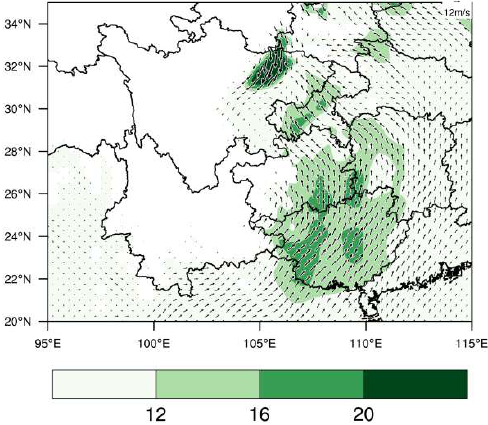
Figure A3. Distributions of wind fields at 850 hPa (vectors, m · s − 1 ), LLJ (shading indicates wind speed over 12 m · s − 1 ) at 2100 UTC 2 May.